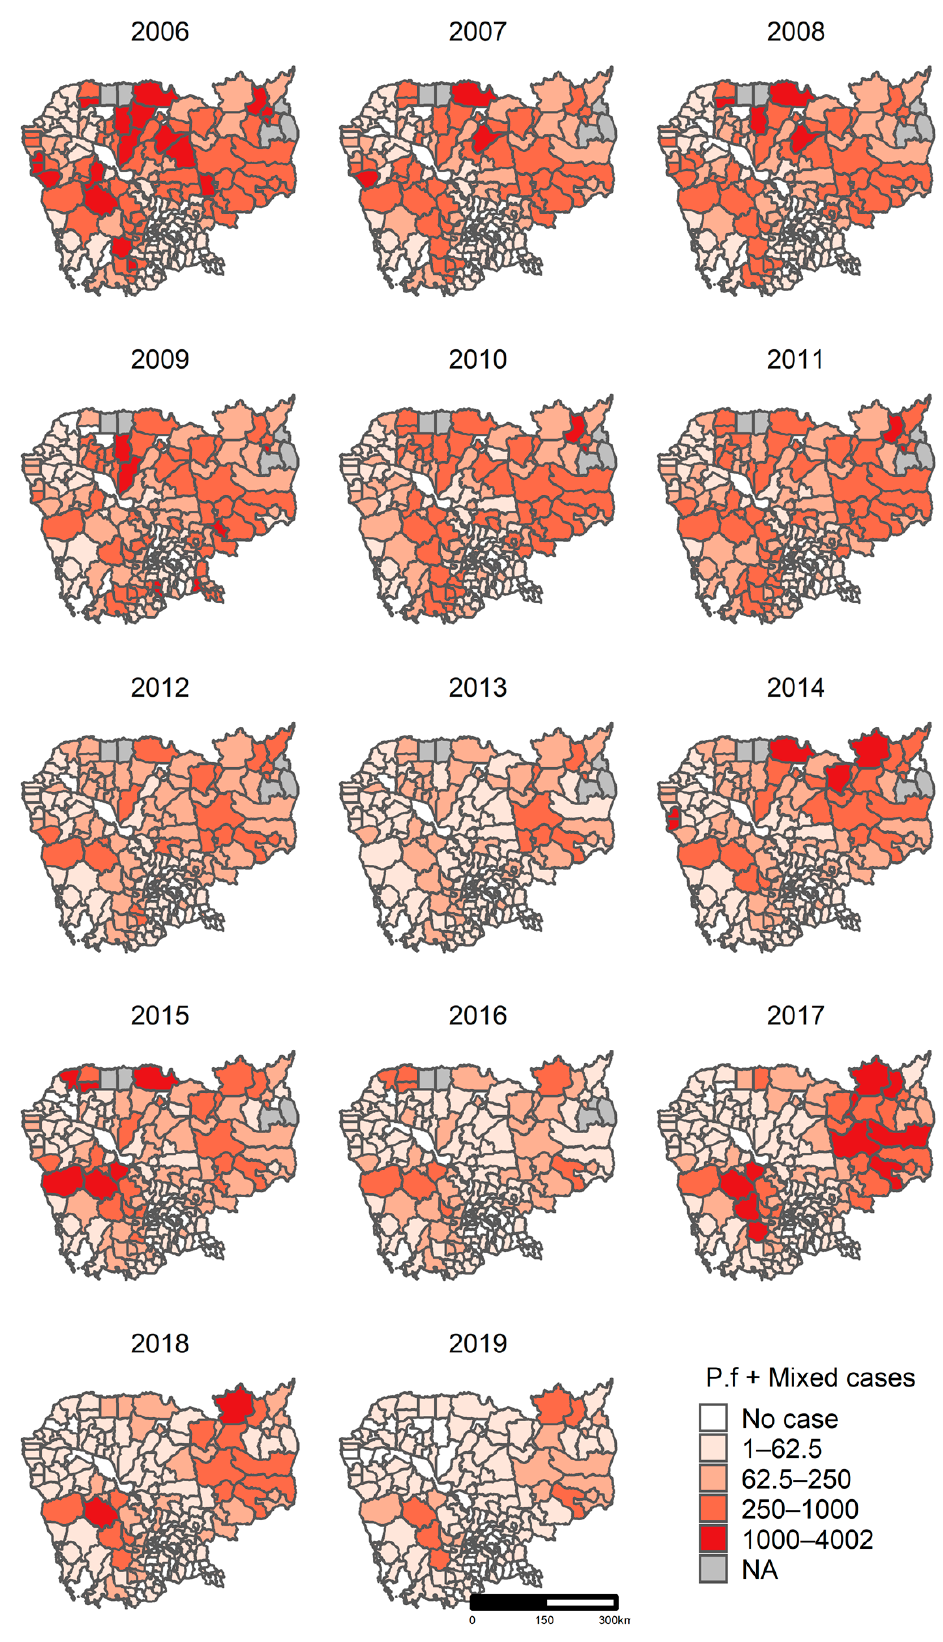
Figure 5. Confirmed P. falciparum + Mixed case distribution by district, 2006–2019, Cambodia. Abbre- viation: NA, not applicable (no